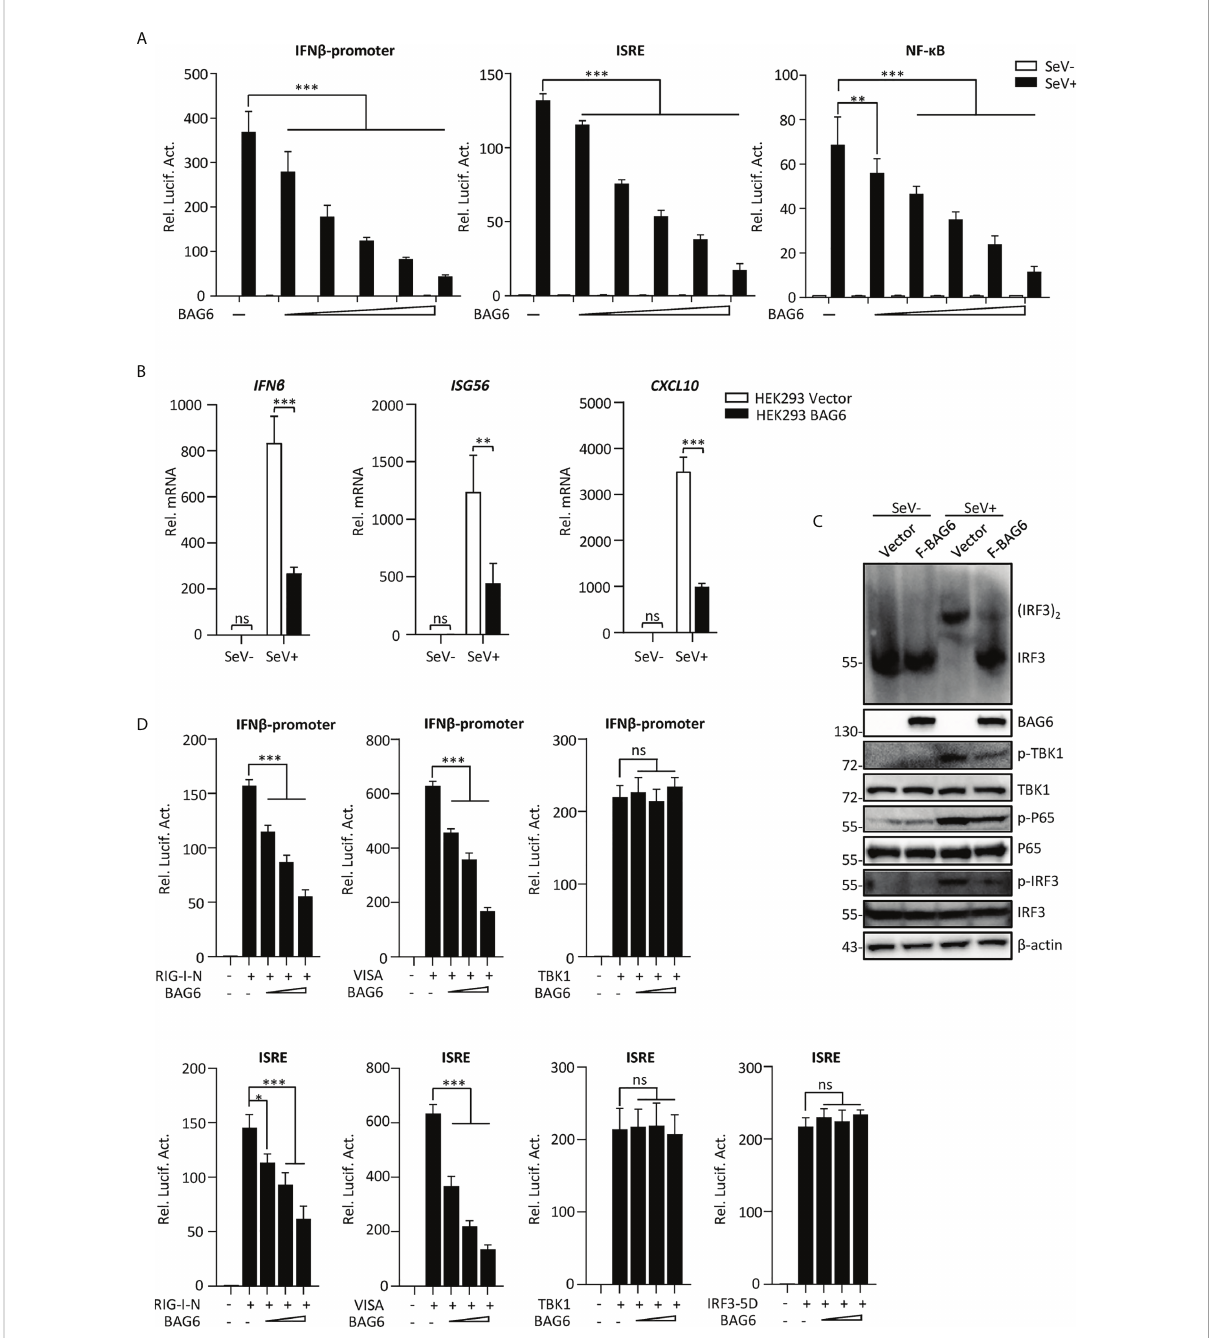
FIGURE 2 Identi fi cation of BAG6 as a negative regulator of RIG-I-mediated signaling. (A) BAG6 inhibits the IFN- b promoter, ISRE, and NF- k B in a dose- dependent manner. HEK 293 cells (1×10 5 ) were transfected with IFN- b promoter (0.025 m g), ISRE (0.025 m g) and NF- k B (0.05 m g) reporter plasmids and BAG6 plasmids (0, 0.05, 0.1, 0.2, 0.4, 0.8 m g). Twelve hours after transfection, cells were infected with SeV (MOI = 1) for 12 h or untreated before luciferase analysis. (B) Overexpression of BAG6 reduces the transcription of downstream antiviral genes. HEK 293 cells were transfected with control or BAG6 plasmid for 24 h. The cells were infected with SeV (MOI = 1) for 12 h or left untreated, followed by qPCR analysis. (C) Overexpression of BAG6 inhibits RNA virus-induced dimerization of IRF3 and phosphorylation of TBK1, P65, and IRF3. HEK 293 cells (2×10 5 ) were transfected with control and BAG6 plasmid for 24 h, and cells were left uninfected or infected with SeV (MOI = 1) for 12 h, followed by immunoblotting analysis. (D) BAG6 inhibits RNA virus-triggered innate immunity by targeting VISA. HEK 293 cells (3×10 5 ) were transfected with IFN- b promoter (0.025 m g), ISRE (0.025 m g), BAG6 plasmids (0, 0.1, 0.2, 0.4 m g) and RIG-I-N, VISA, TBK1 or IRF3-5D (0.5 m g) for twenty h before luciferase analysis. (* p < 0.05; ** p < 0.01; *** p < 0.001; ns, no signi fi cant